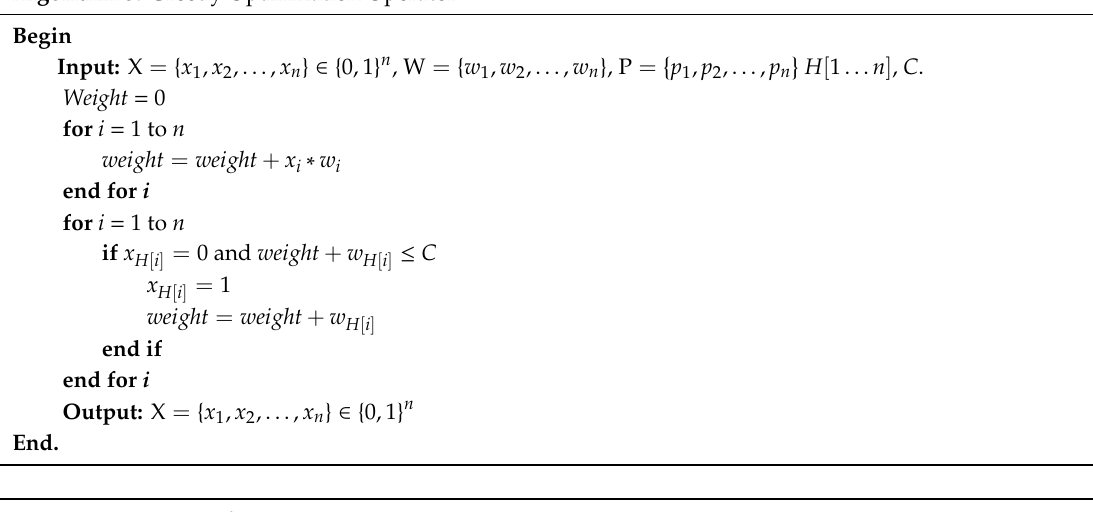
Algorithm 6. GMBO for 0-1